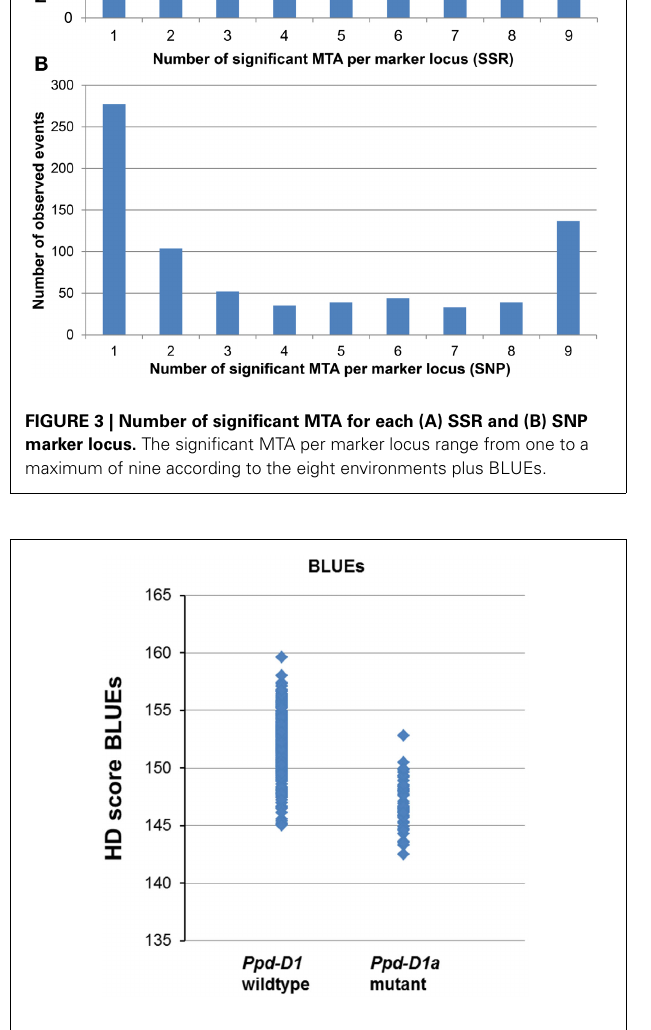
FIGURE 4 | Allelic effects for Ppd-D1 in a population of 372 European wheat varieties. Varieties carrying the mutant allele Ppd-D1a showed a decreased HD score BLUES resulting in an earlier